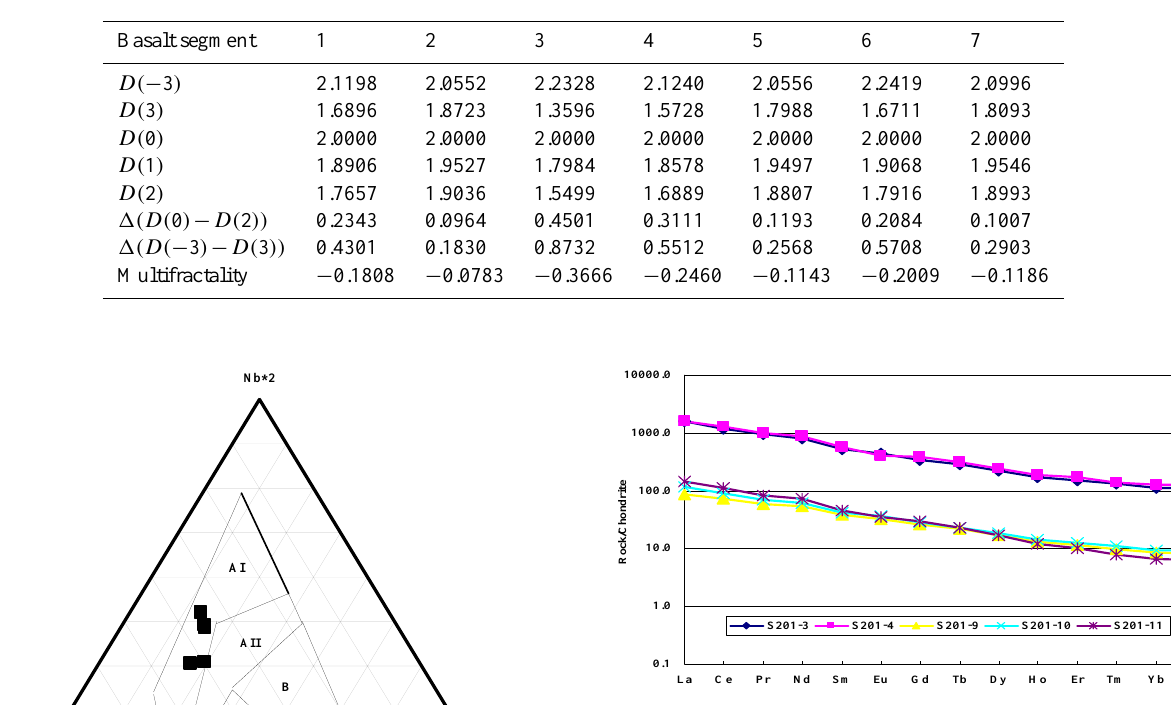
Fig. 5 . Chondrite-normalized REE distribution patterns Fig. 5. Chondrite-normalized REE distribution patterns. (Normal- (Normalizing values from Sun and Mc Donough(1989)) izing values from Sun and Mc Donough, 1989.) Fig. 5 does show th s. It can be seen that all e Chondrite-normalized REE distribution pattern amples show slightly sloping chondrite-normalized REE patterns, rich in light rare earth the s elements (LREE, La-Sm) but depleted in heavy rare earth elements (HREE, Eu-Lu), with ((La) N /(Yb) N values ranging from 7.1 to 21.5. Samples 201-4 and 201-11 have weakly negative Eu anomalies. The REE distribution patterns of samples 201-3 and 201-4 are similar to each other and their total REE contents are 1883.38ppb and 1973.74ppb, respectively, and higher than those of other samples raging from 118.17 to167.92ppb. type MORB; D = normalized trace element concentrations. In Fig. 6, both the samples 201-3 and 201-4 show identical patterns with incompatible elements enriched, but high field strength el- ements (HFSEs, U and Th) and heavy rare earth elements (HREE, Eu-Lu) of these two samples are relatively